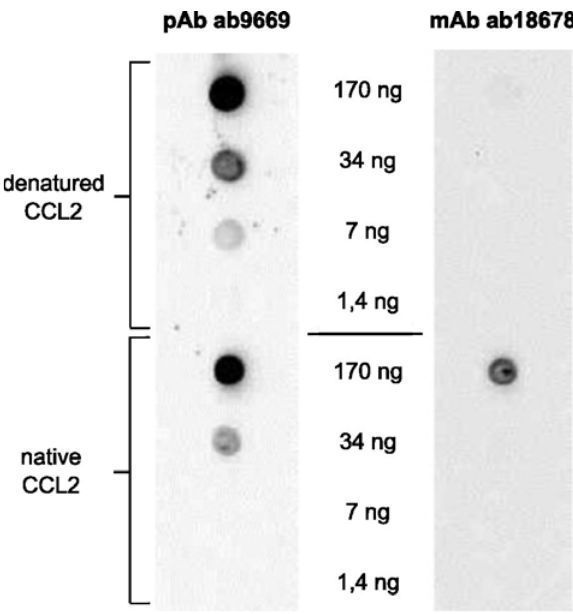
Figure 2: Immuno-dot-blot assay of polyclonal antibody (pAb) ab9669 and monoclonal antibody (mAb) ab18678 interaction with denatured and native forms of recombinant